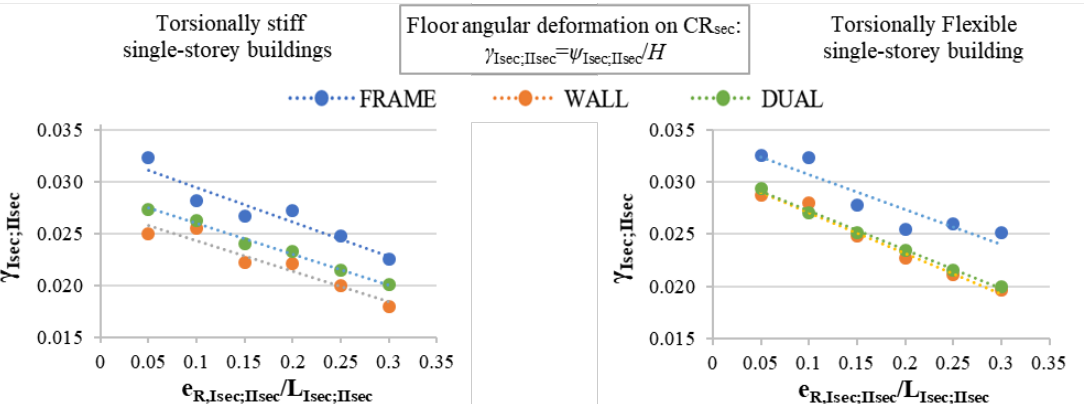
and 𝛾 , at the location of CR , along the 𝐼 or 𝐼𝐼 Isec IIsec sec sec sec and 𝜓 of the proposed Displacement- Isec IIsec Based pushover. (rad) about vertical axis of the proposed Displacement-Based pushover in R